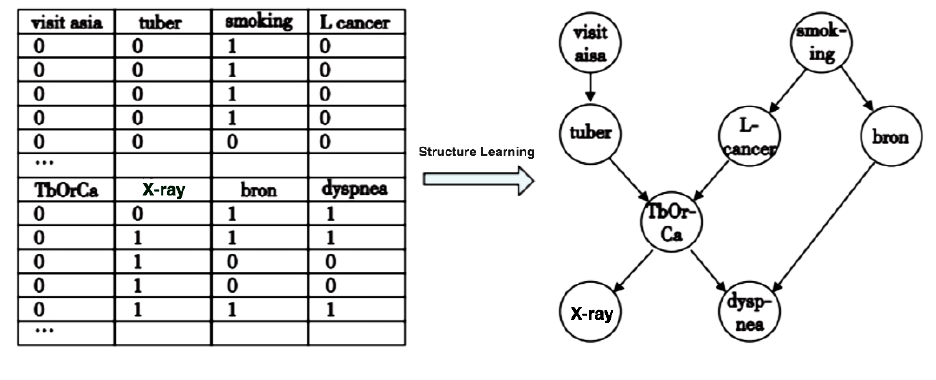
( b ) Bayesian network structure learning. Figure 1. Asia network and Bayesian network structure learning. Figure 1. Asia network and Bayesian network structure